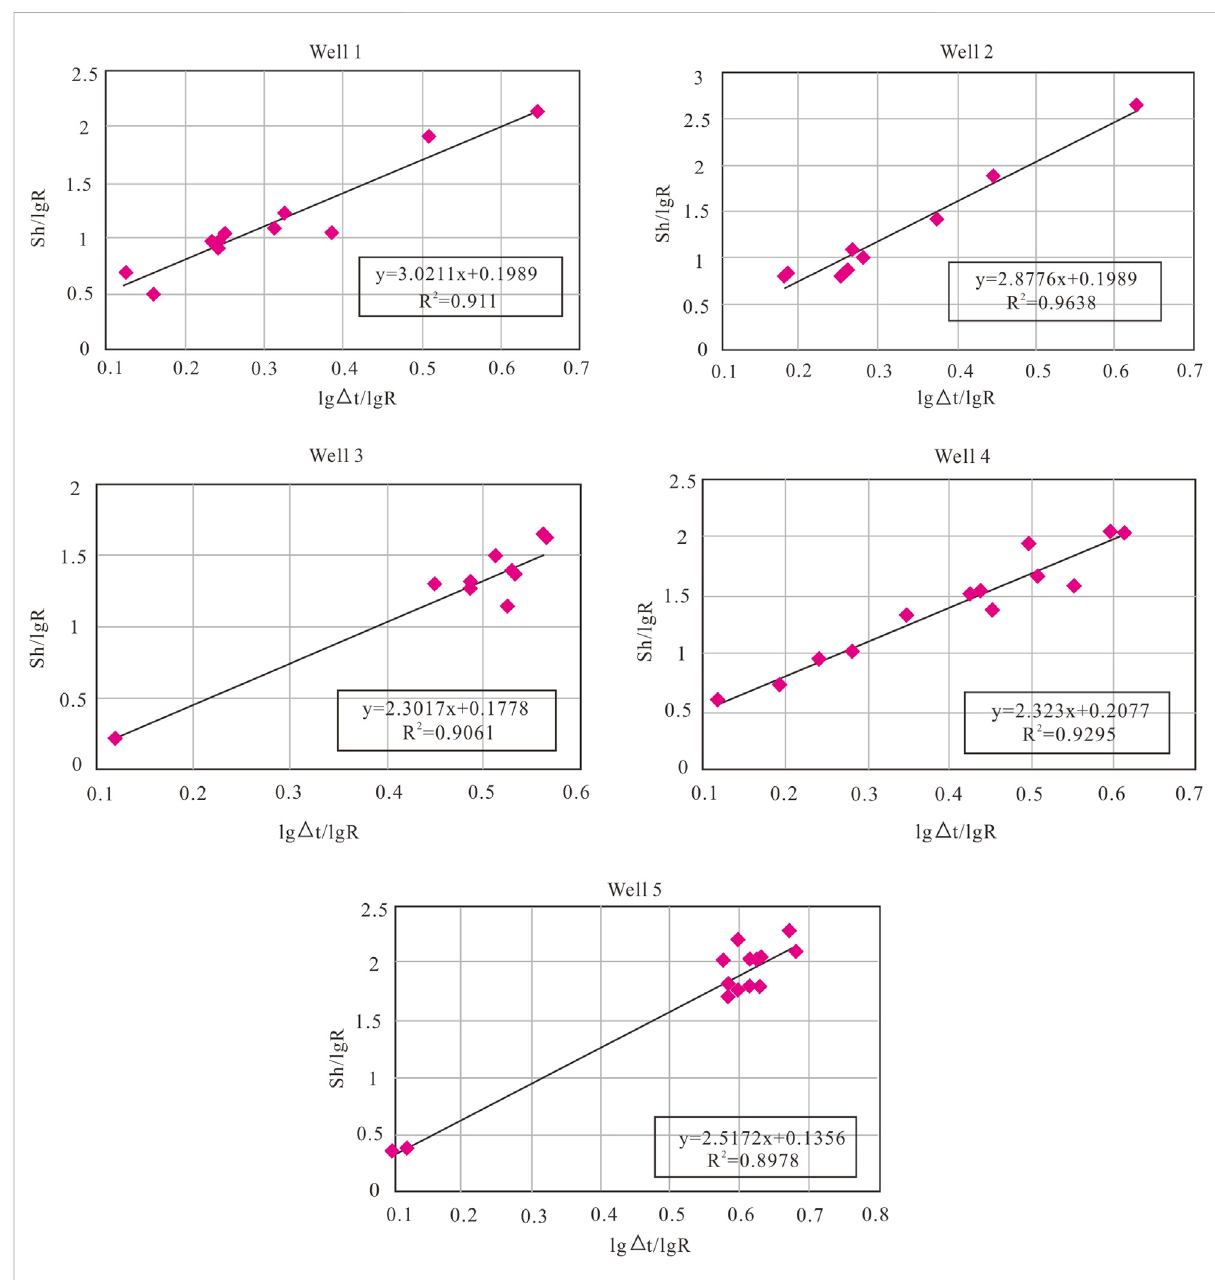
FIGURE 2 The coef fi cient fi tting diagram of fi ve wells in study